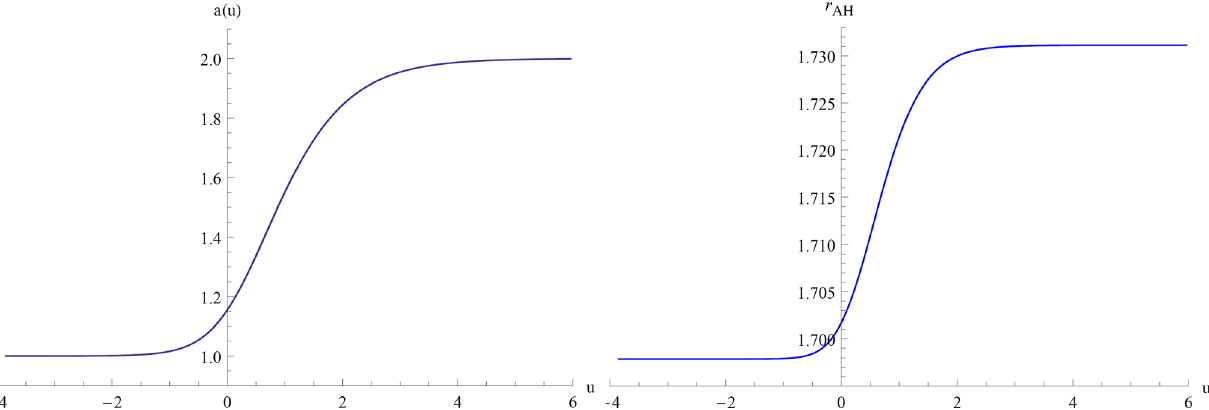
g = 1 ,γ 1 = 9 / 10. The location of the event/apparent horizon for the initial and final stable black hole are r h respectively